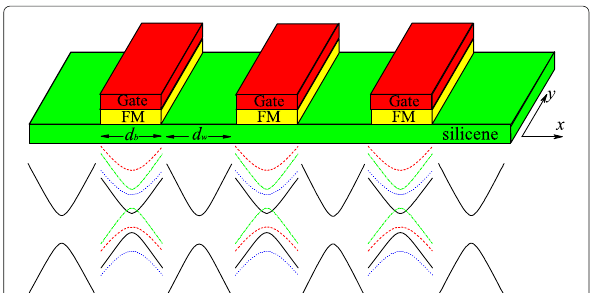
Fig. 1 Top: schematic of the silicene superlattices. The FM insulators, such as EuO and EuS, on the top of silicene induce the exchange fields in silicene, as proposed for graphene [53]. The metallic gates on the top of FM insulators control the Fermi level locally. Bottom: schematic of the energy spectrum in silicene with and without external